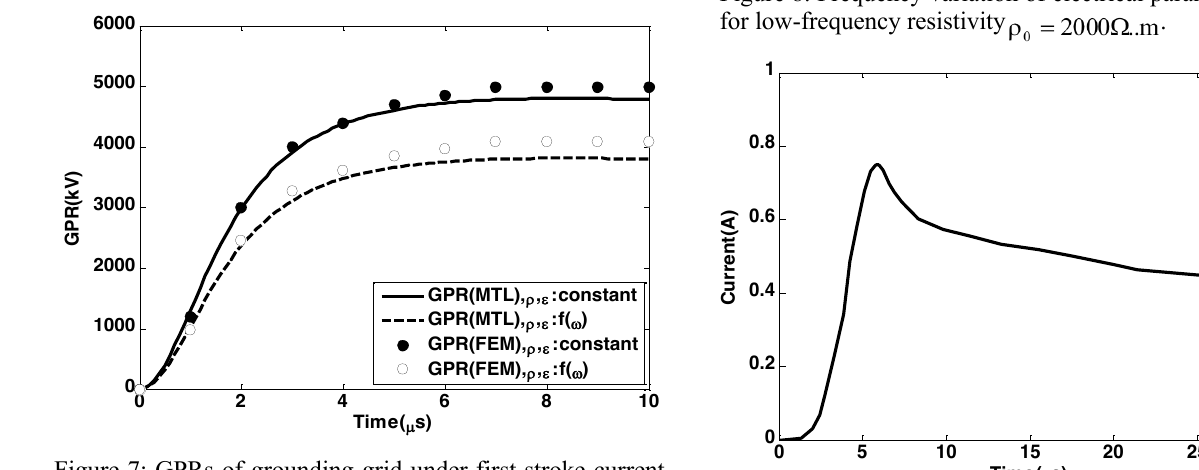
Figure 6: Two typical lightning current waveforms namely first and subsequent stroke used in the first example. Adapted from [4].